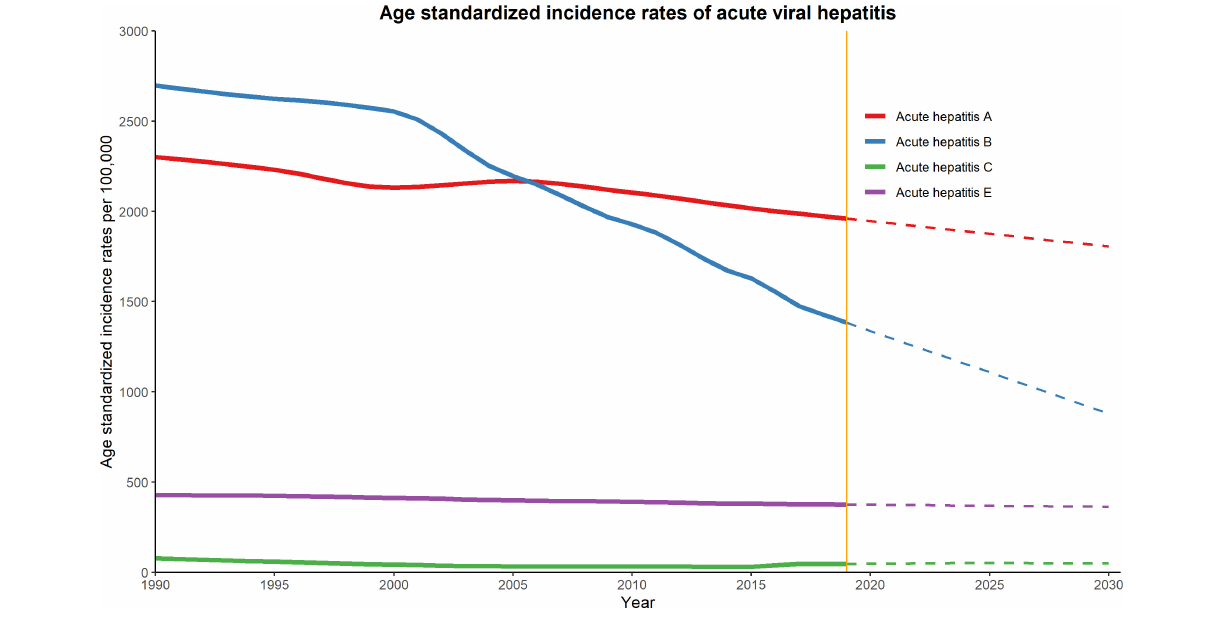
were fully paid by the government (17). In addition, there was a hepatitis B vaccine coverage in rural areas from 2009 to